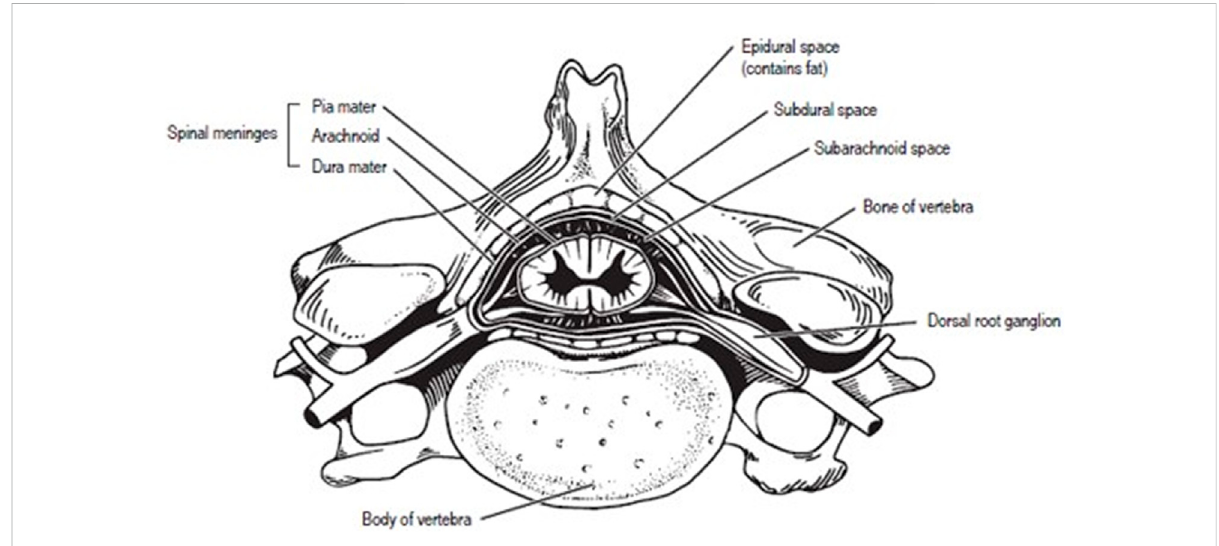
FIGURE 1 Human Vertebra with labeled spinal cord.